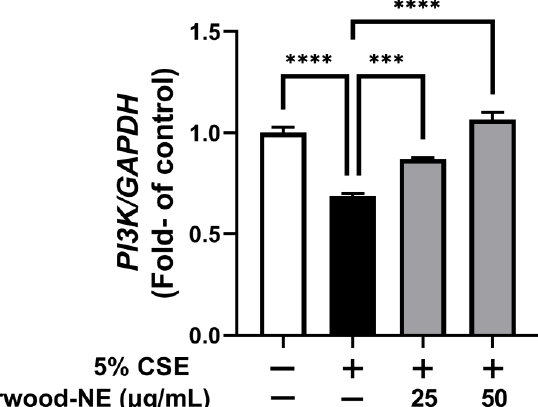
Figure 6. Effect of Agarwood-NE on the CSE-inhibited transcription of the pro-survival gene PI3K. BCi-NS1.1 cells were pre-incubated for 1 h in the presence of 25 and 50 µ g/mL agarwood-NE, followed by exposure to 5% CSE for 24 h. The mRNA levels of PI-3K were determined via RT-qPCR. Values are expressed as mean ± SEM ( n = 4, ***: p < 0.001; ****: p <